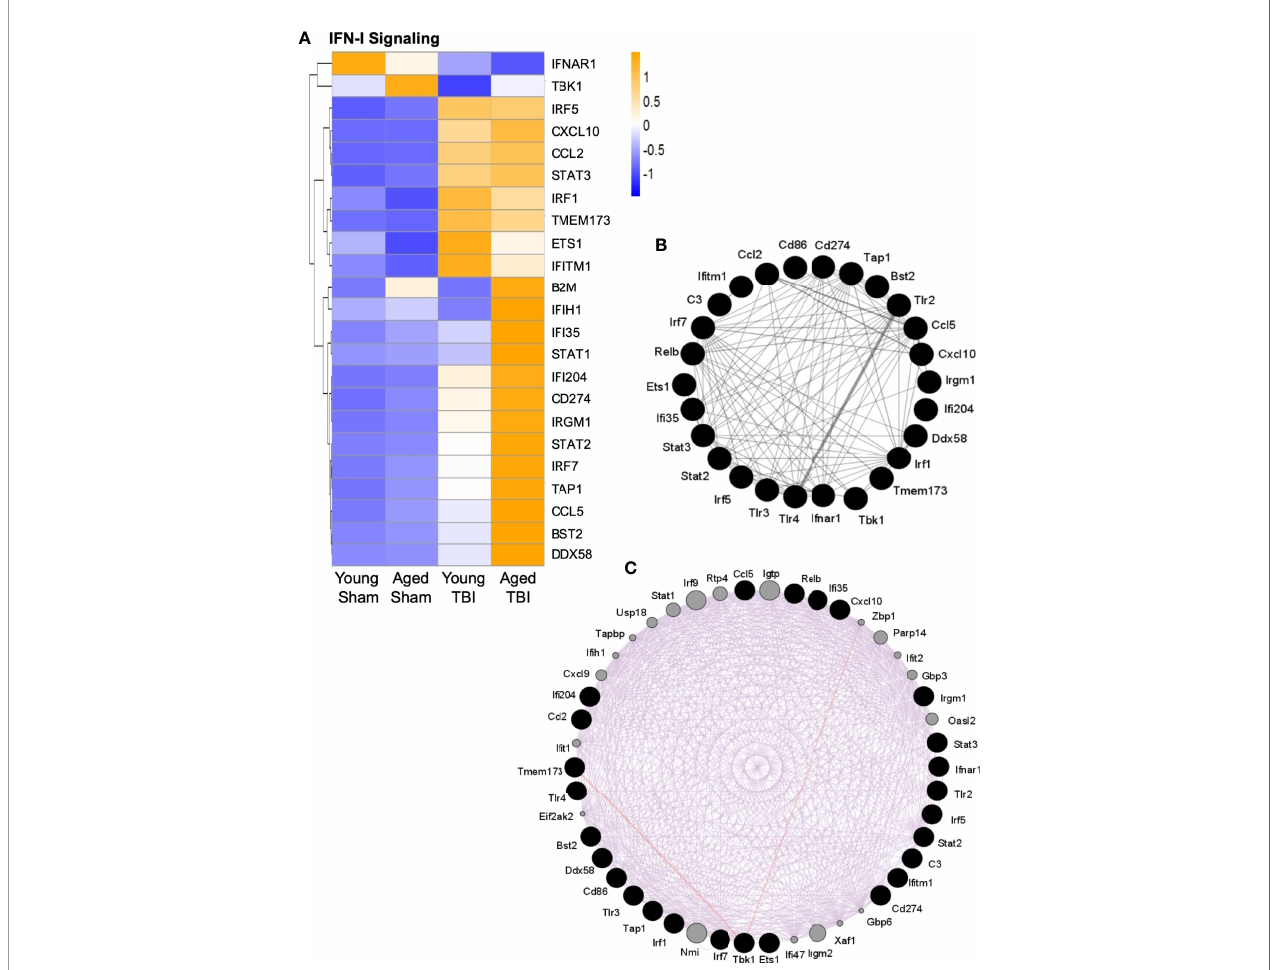
FIGURE 5 | Interaction analysis of selected genes related to IFN-I signaling. Selected transcripts were grouped by known or suspected functions related to IFN-I signaling (A) . For most but not all transcripts, TBI increases expression. For some transcripts, TBI in aged mice shows the highest level of expression, and this age effect was statistically signi fi cant for several transcripts. The heat map color scale re fl ects normalized log-transformed raw counts scaled to z-scores, where -1=darker blue=decreased expression and 1=darker yellow=increased expression. (B, C) GeneMania (http://www.genemania.org) was used to generate an expression interaction between genes represented in (A) . Black nodes are the query genes (from A) and the connections/edges are colored based on interaction type, where (B) grey is for interactions between genes whose expression was altered (A, C) purple is for predicted interactions between genes in (A) (black nodes) and other genes (grey nodes) based on literature citations. The width of the edges is controlled by the evidence of the interaction, where thicker edges denote more evidence of interaction between the attached genes/nodes. Speci fi c interaction values for each gene are shown in Supplemental Table 6